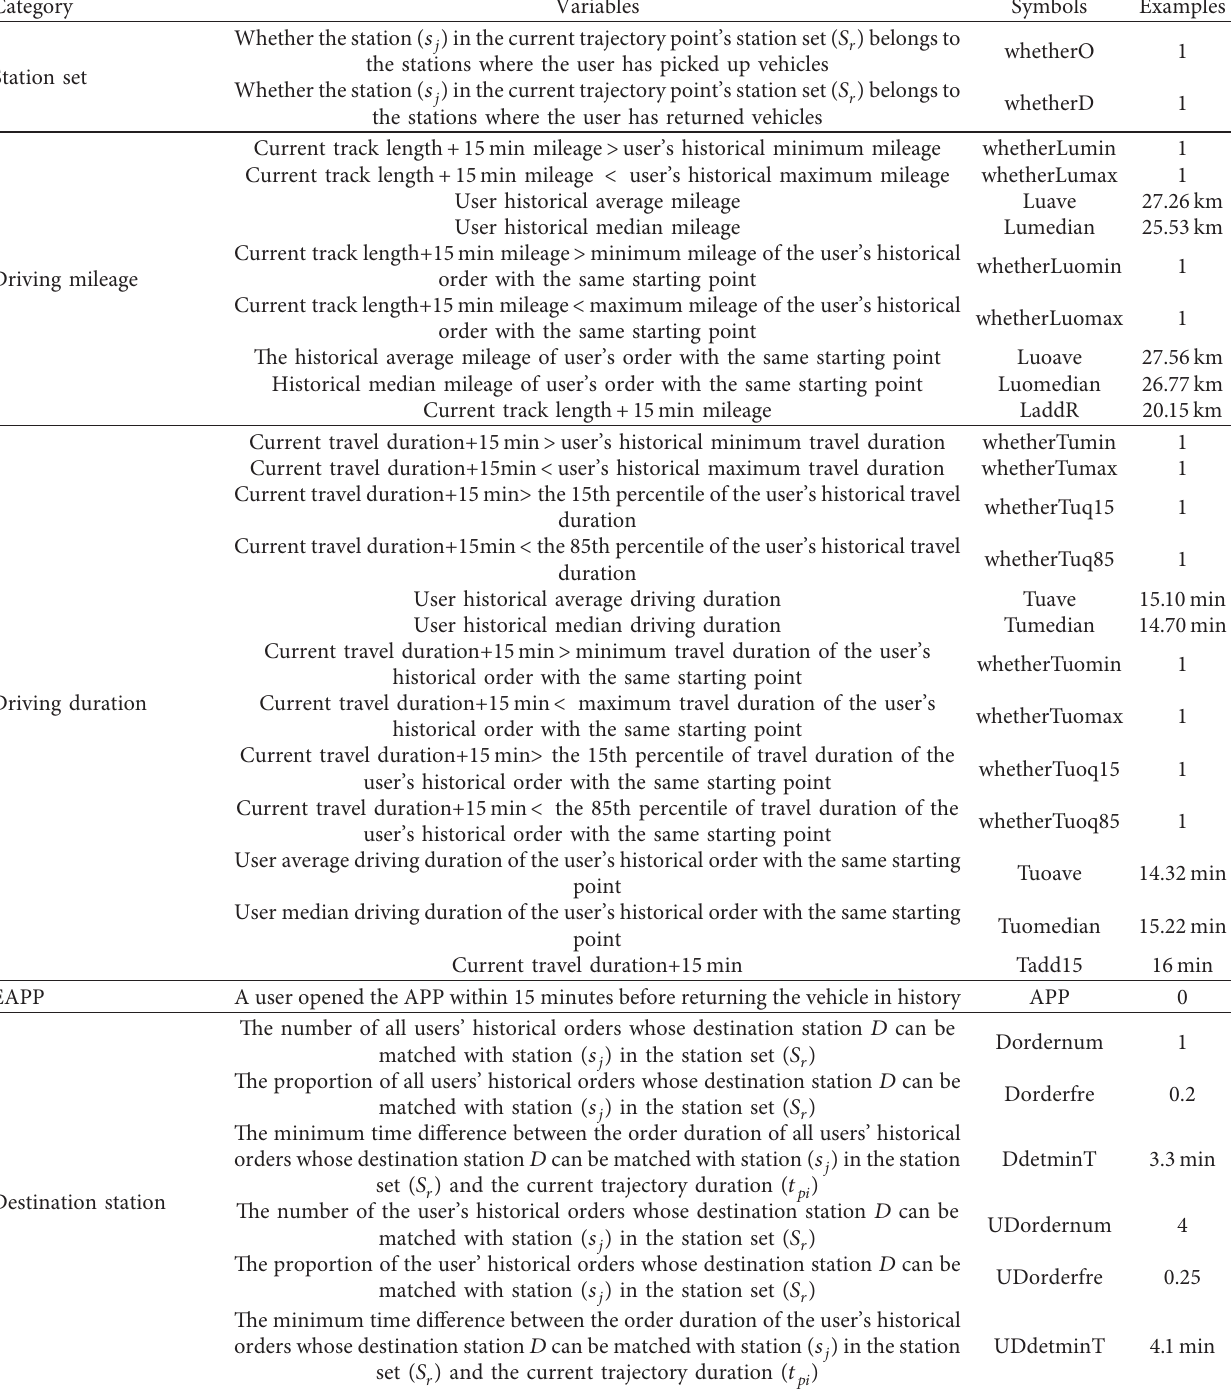
Table 1: Characteristic variables and